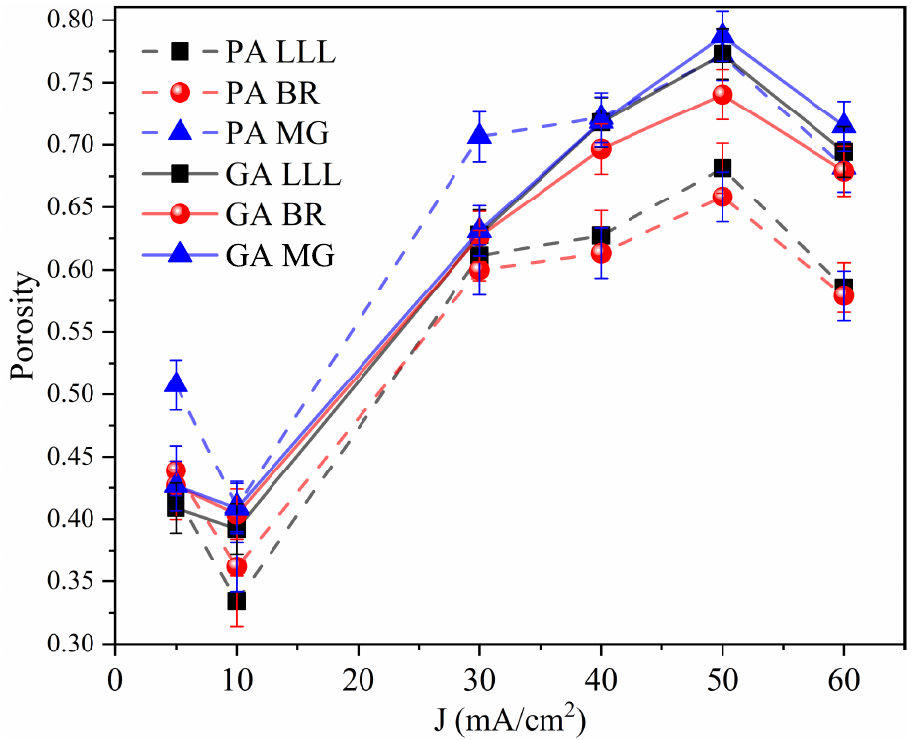
Figure 10. Porosity as a function of current density estimated by EMA rules combined with in situ photoacoustic (PA) and genetic algorithms